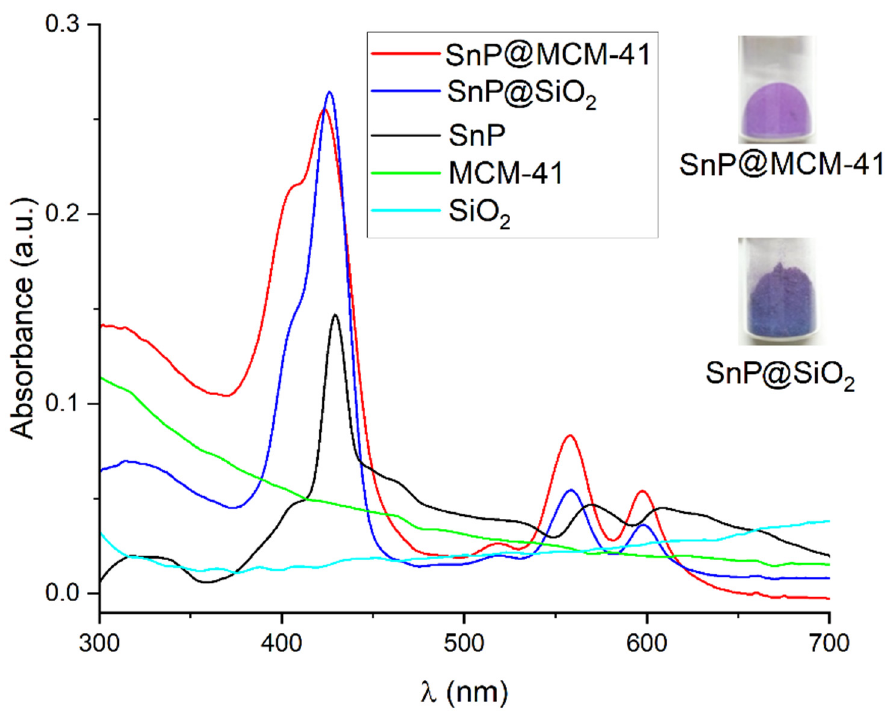
Figure 2. Solid-state UV–vis absorption spectra of SnP , SiO 2 , MCM − 41, SnP@MCM − 41 , and